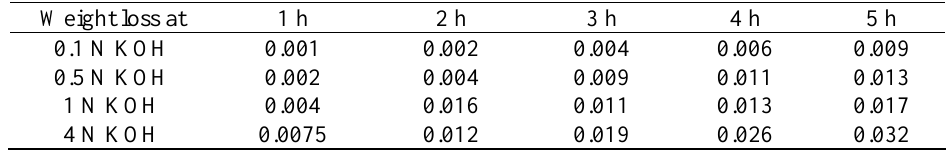
Table 11. Weight loss of Brass in HNO